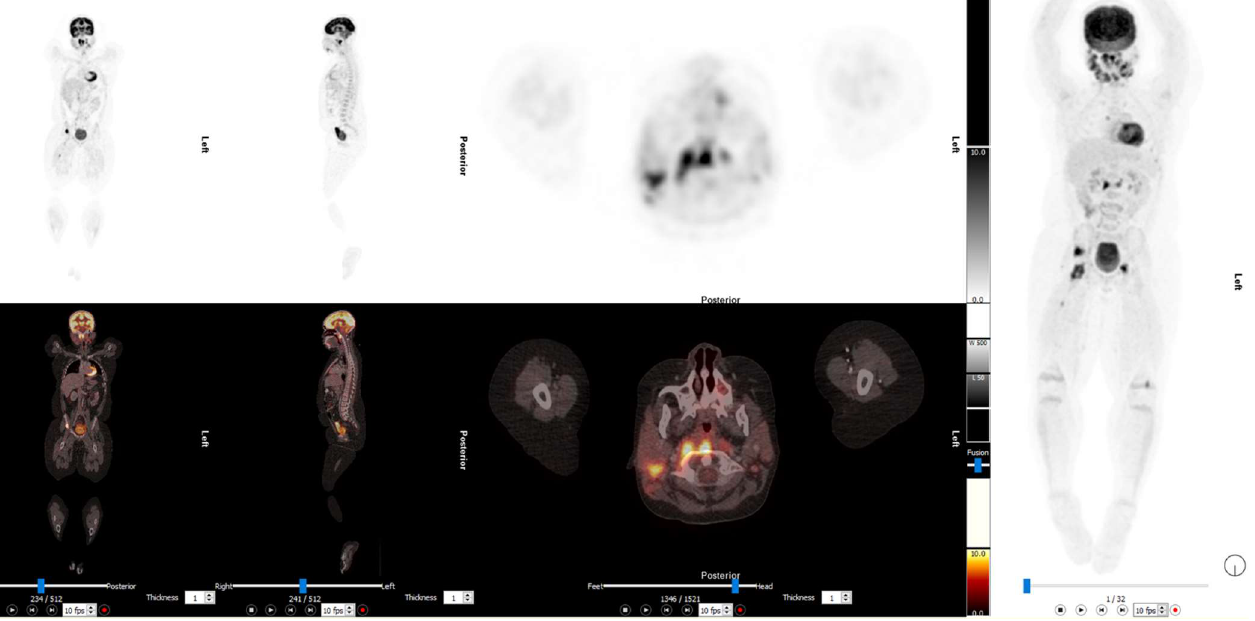
Figure 4. The 2-[ 18 F]FDG PET/CT images of a 10-year-old with recurrent LCH being worked up for a stem cell transplant. There is evidence of significant disease in the nasopharynx with multiple skeletal lesions. This illustrates the value of 2-[ 18 F]FDG PET/CT for re-staging prior to treatment.